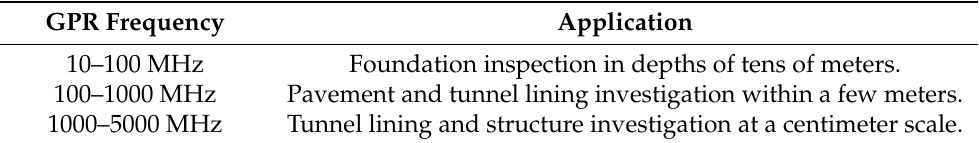
Table 3. GPR antenna frequency range and application according to [26].